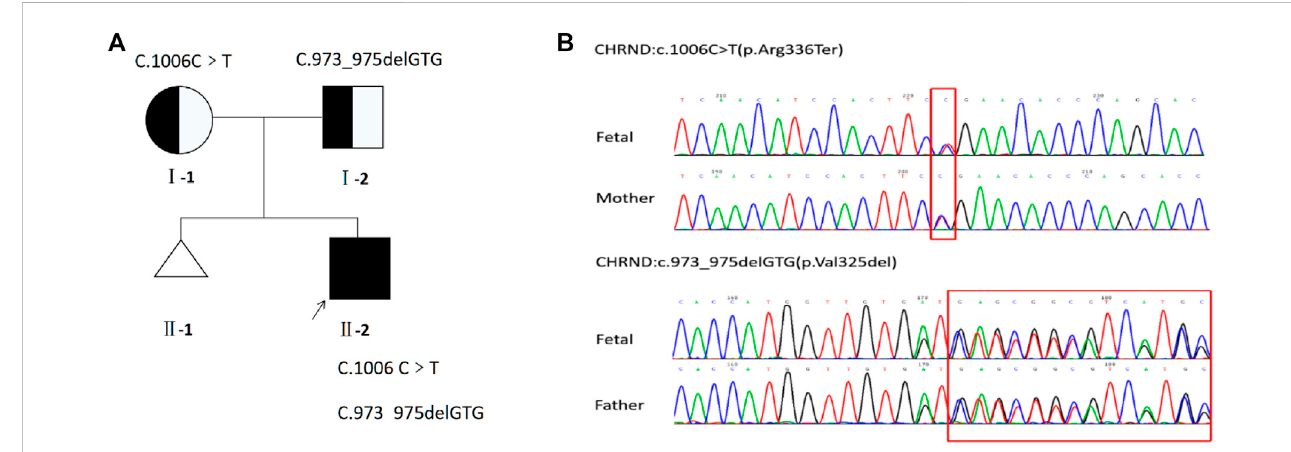
FIGURE 4 (A) Pedigreeofthefamily. (B) Sequencing of CHRND gene (referencecDNAsequence,NM_000751.2)revealed twoheterozygousvariations, resultingin C to T substitution at nucleotide position 1006 [c.1006C > T p.(Arg336Ter)] and GTG deletion at nucleotide position 973 to 975 [c.973_975delGTG